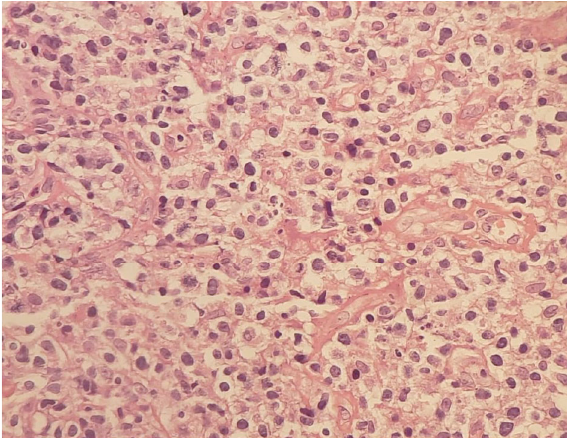
Figure 6: Endoscopic biopsy specimen (H&E x20). Microphotograph shows the H&E-stained section showing di ff use proliferation of atypical cells with apoptotic